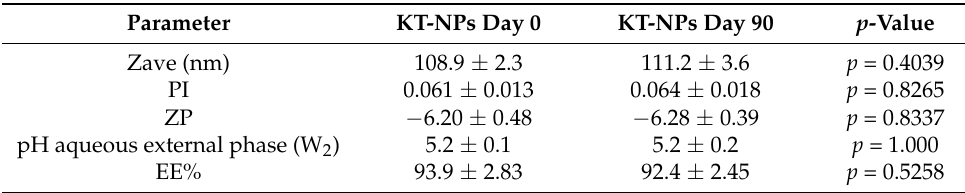
Table 2. Comparison of the particle size (Zave), polydispersity index (PI), zeta potential (ZP), pH of the external aqueous phase and encapsulation efficiency (EE) from the KT-NPs at time 0 and time 90 days ( n = 3) stored at 4 ◦ C. Results are expressed as mean ± standard deviation.